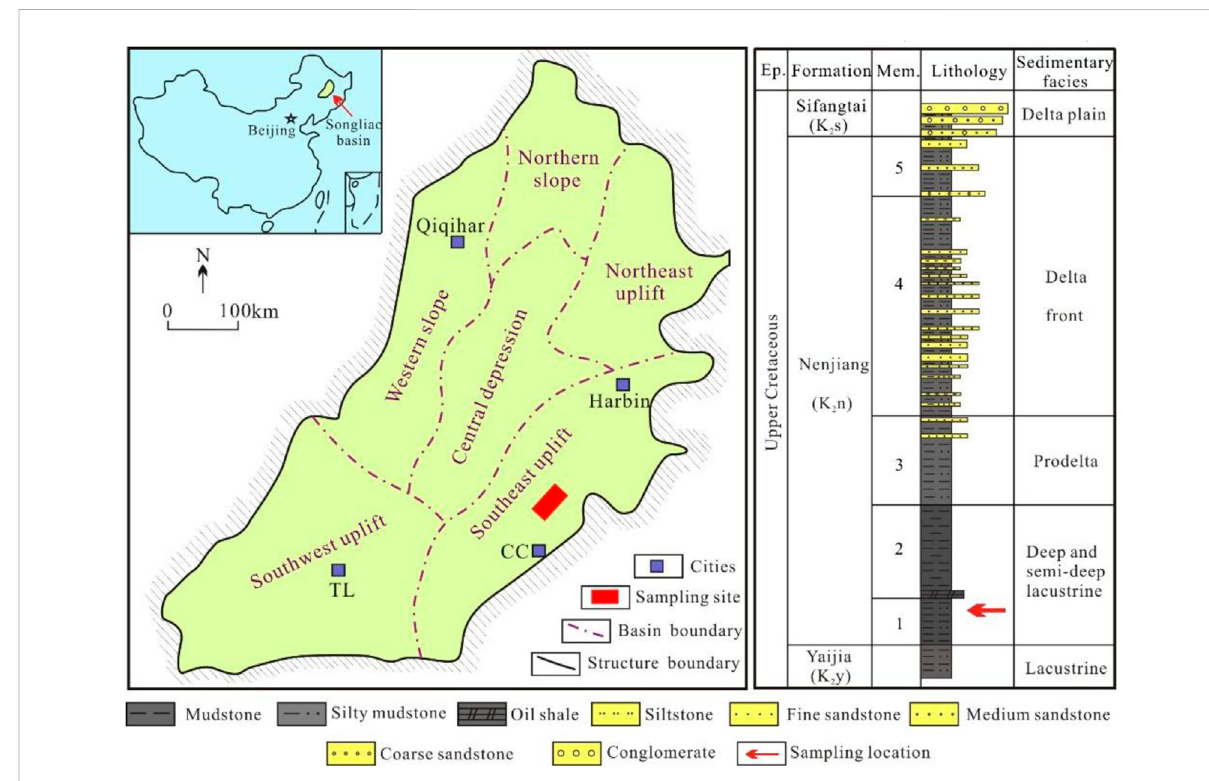
FIGURE 2 Location of the sampling site in the Songliao Basin and stratigraphic pro fi le of the Nenjiang Formation.